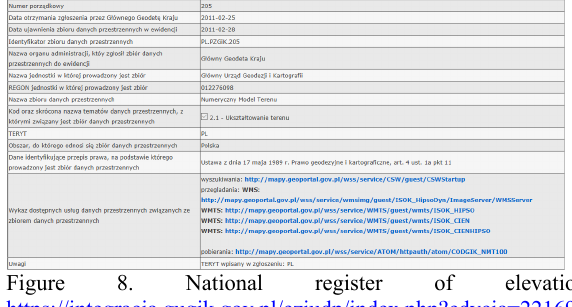
8. National register of elevation https://integracja.gugik.gov.pl/eziudp/index.php?edycja=22169 Head Office of Geodesy and Cartography in Poland